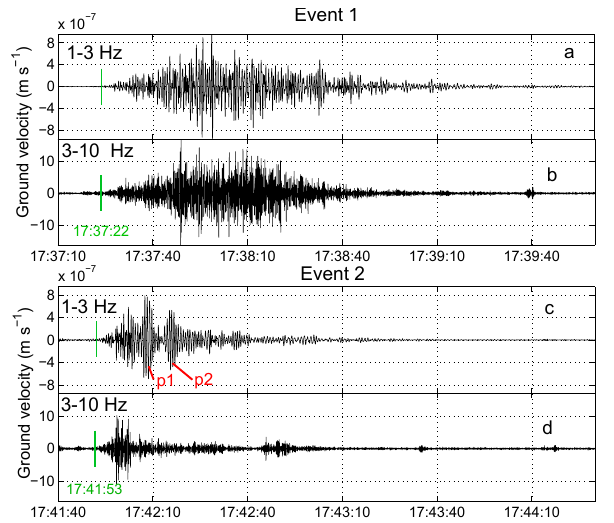
Figure 3. Seismic signals in detail for (a) and (b) event 1, and for (c) and (d) event 2 at station JCW, filtered between 1–3Hz and 3– 10Hz, respectively. The onset time for both signals is indicated by the green line. Labels p1 and p2 indicate the two amplitude peaks observed only in the seismic signal of the second event filtered in the 1–3Hz frequency